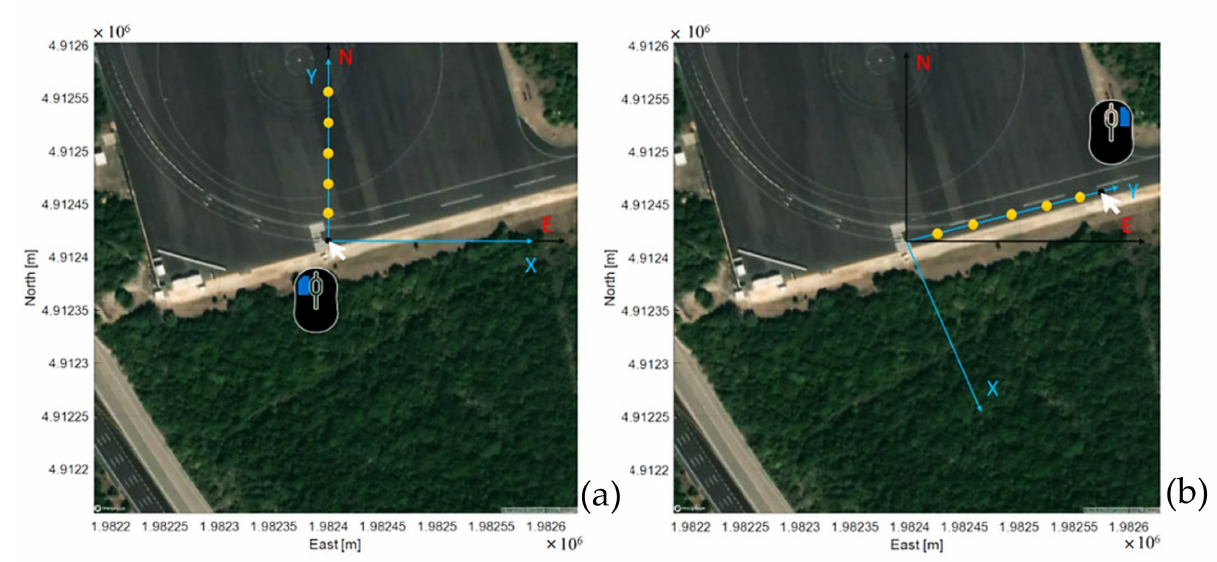
Figure 11. Interface of the Matlab Mapbox tool; choice of the origin by left-clicking on a point ( a ) and choice of the y -axis orientation by right-clicking on another point ( b